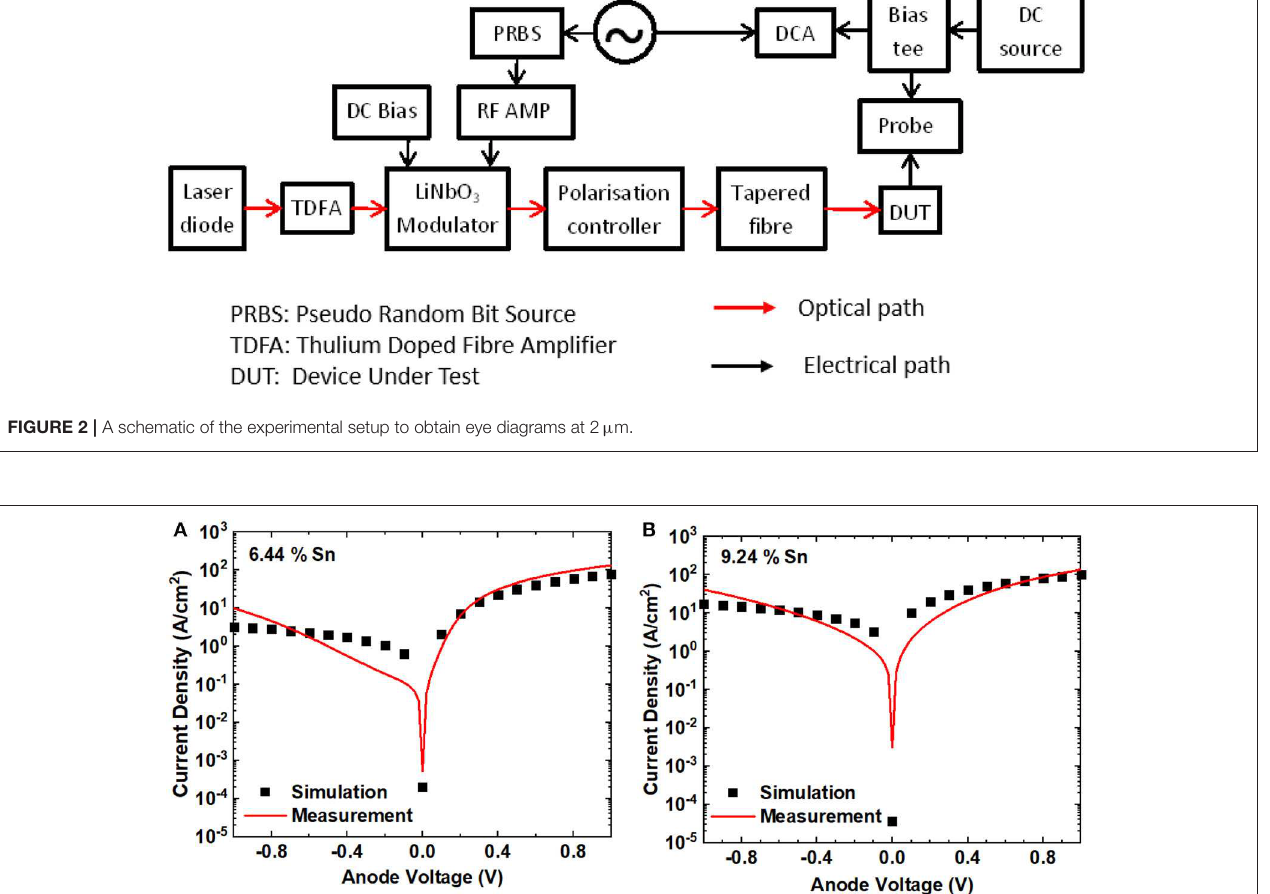
FIGURE 3 | Simulated and measured J-V characteristics of (A) the Ge 0.9356 Sn 0.0644 device and (B) the Ge 0.9076 Sn 0.0924 device.